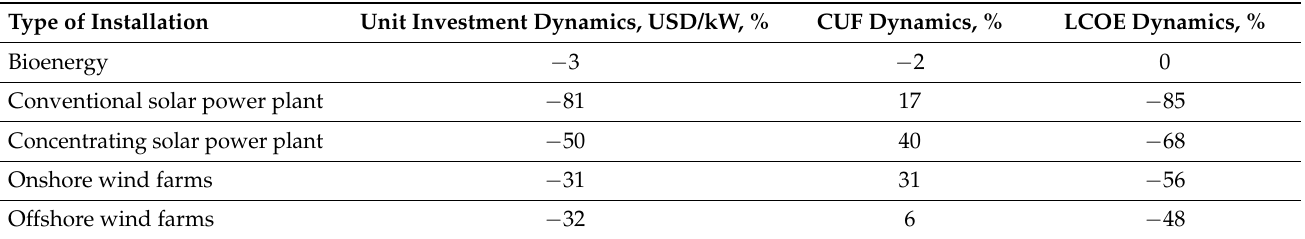
Table 1. Dynamics of average technical and economic characteristics of various renewable generation facilities in 2010–2020